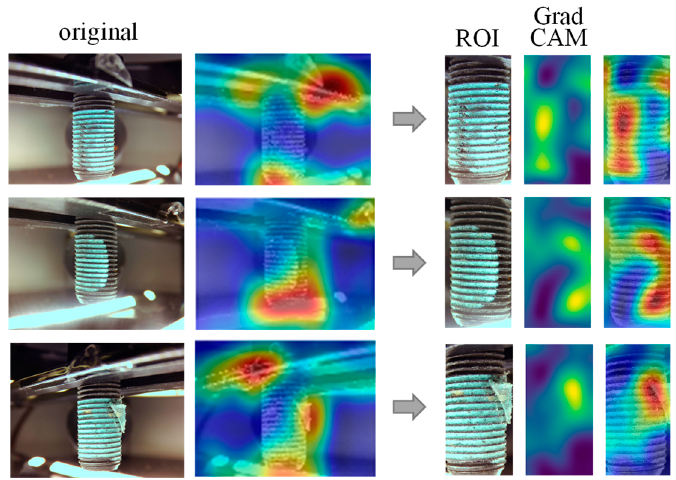
Figure 7. Visualization using Grad-CAM ( left ) and improved defect detection using the ROI method ( right ).